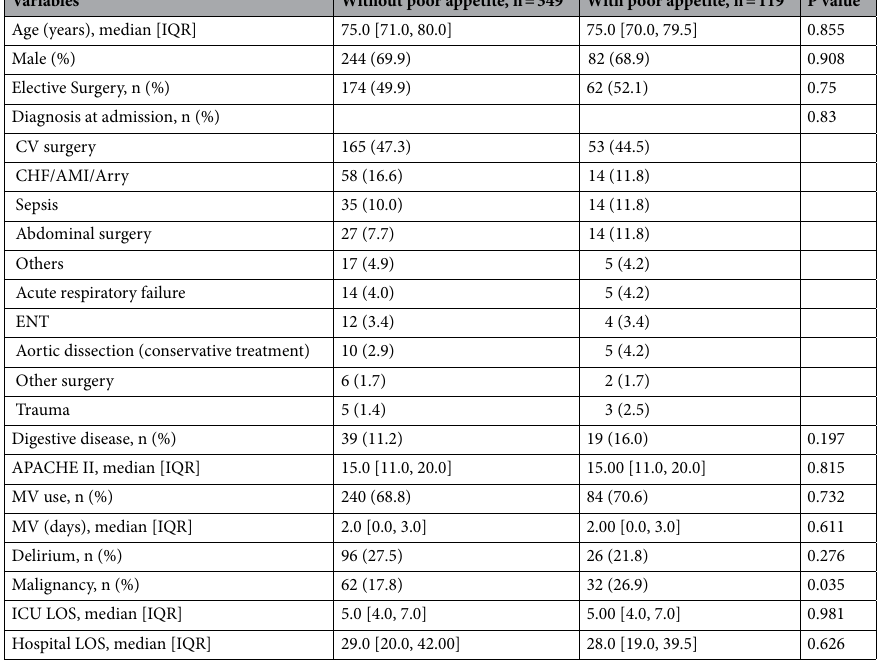
Table 2. Comparison of characteristics between groups. IQR, interquartile range; CV, cardiovascular; CHF/ AMI/Arrhy, congestive heart failure/acute myocardial infarction/arrhythmia; Abd surgery, abdominal surgery; ENT, ear nose throat; APACHE II, Acute Physiology and Chronic Health Evaluation II; MV, mechanical ventilation; ICU, intensive care unit; LOS, length of stay.